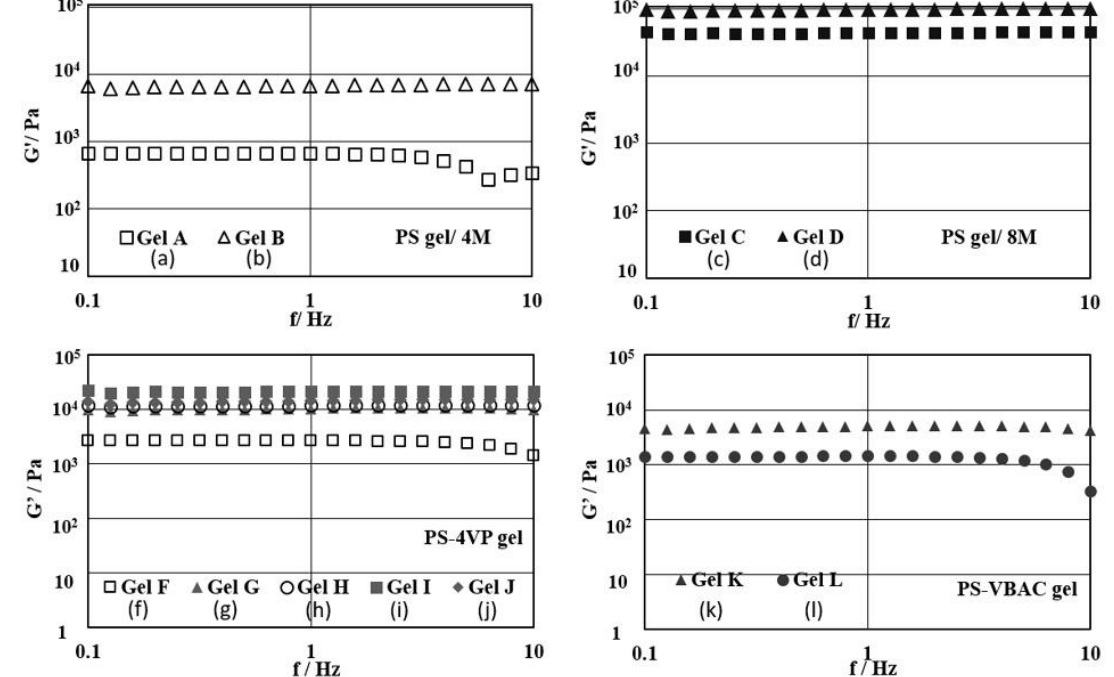
Figure 3. Elastic modulus (G’) from rheological measurement at frequency 0.1–10 Hz of 5 mol % cross-linker PS gel; Gel A ( a ) and Gel B ( b ), 10 mol % cross-linker PS gel; Gel C ( c ) and Gel D ( d ), PS-4VP gel; Gel F ( f ), Gel G ( g ), Gel H ( h ), Gel I ( i ) and Gel J ( j ) and PS-VBAC; Gel K ( k ) and Gel L ( l ) in d-limonene, ( n =